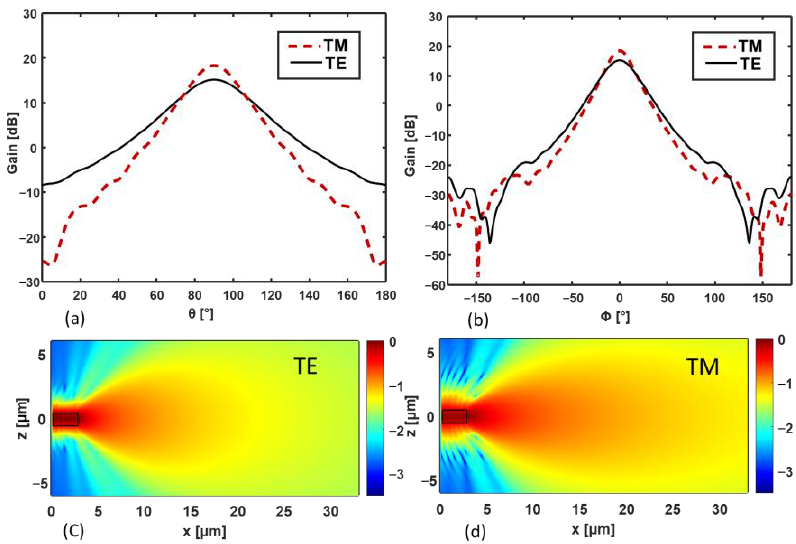
Figure 4. ( a , b ) Gain as a function of ( a ) the angle θ (with Φ = 0) and ( b ) the angle Φ (with θ = π/2), for the TE (solid curves) and TM (dashed curves) modes in the case of the truncated waveguide. ( c , d ) Electric field pattern calculated via 3D-FDTD in the xy plane for z = 0 µ m (i.e., in the middle of the antennas) for the TE ( c ) and TM ( d ) polarizations. The color bar represents the normalized amplitude of the electric field in logarithmic scale. The wavelength is λ = 1.55 µm.